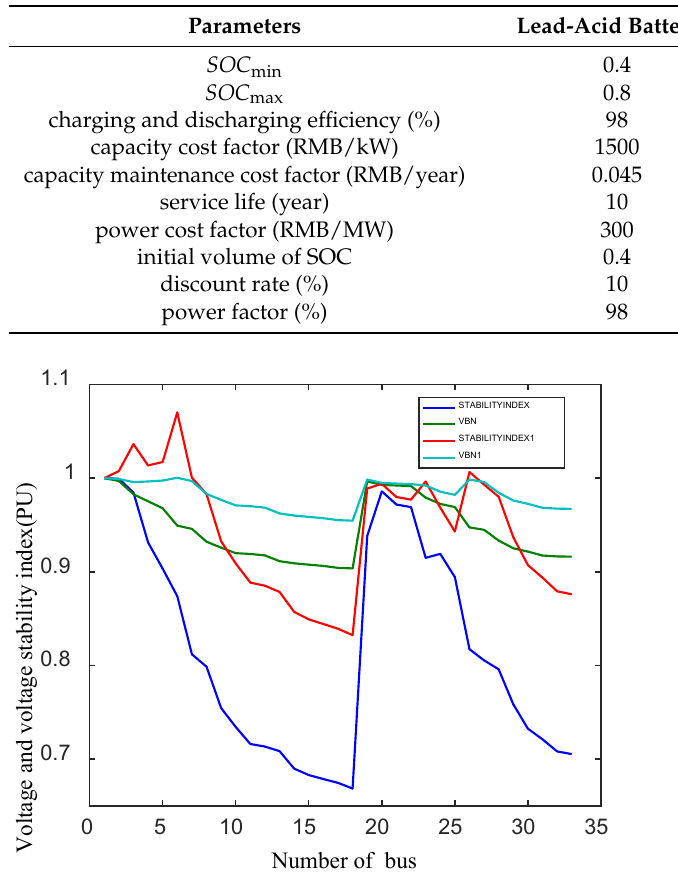
Figure 6. Voltage stability index for different access points. Table 2. Effect of different access points on grid voltage and stability. VBN: Voltage of the branch node.